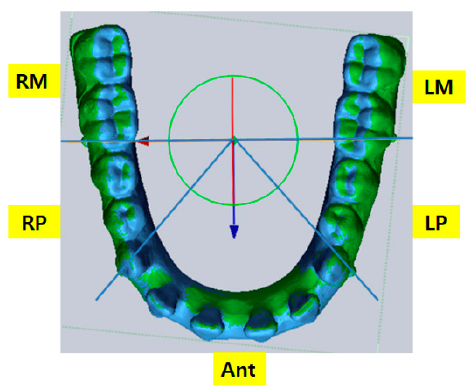
Figure 5. Superimposed model divided into five Sections. LM: left molars, LP: left premolars, Ant: anterior, RP: right premolars, RM: right molars.